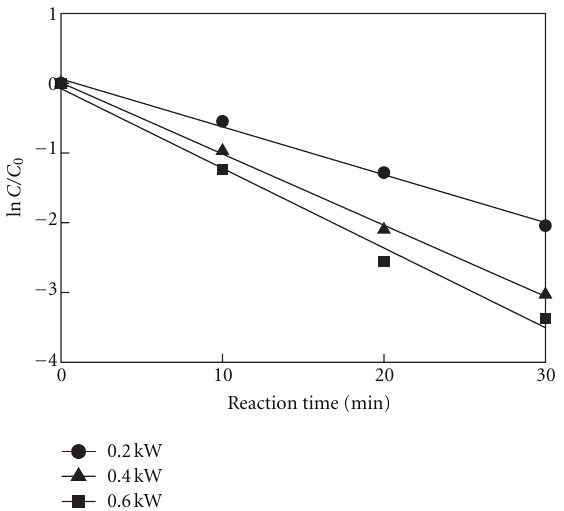
Figure 5: E ff ect of microwave intensity for decomposition of methylene blue in aqueous solution.